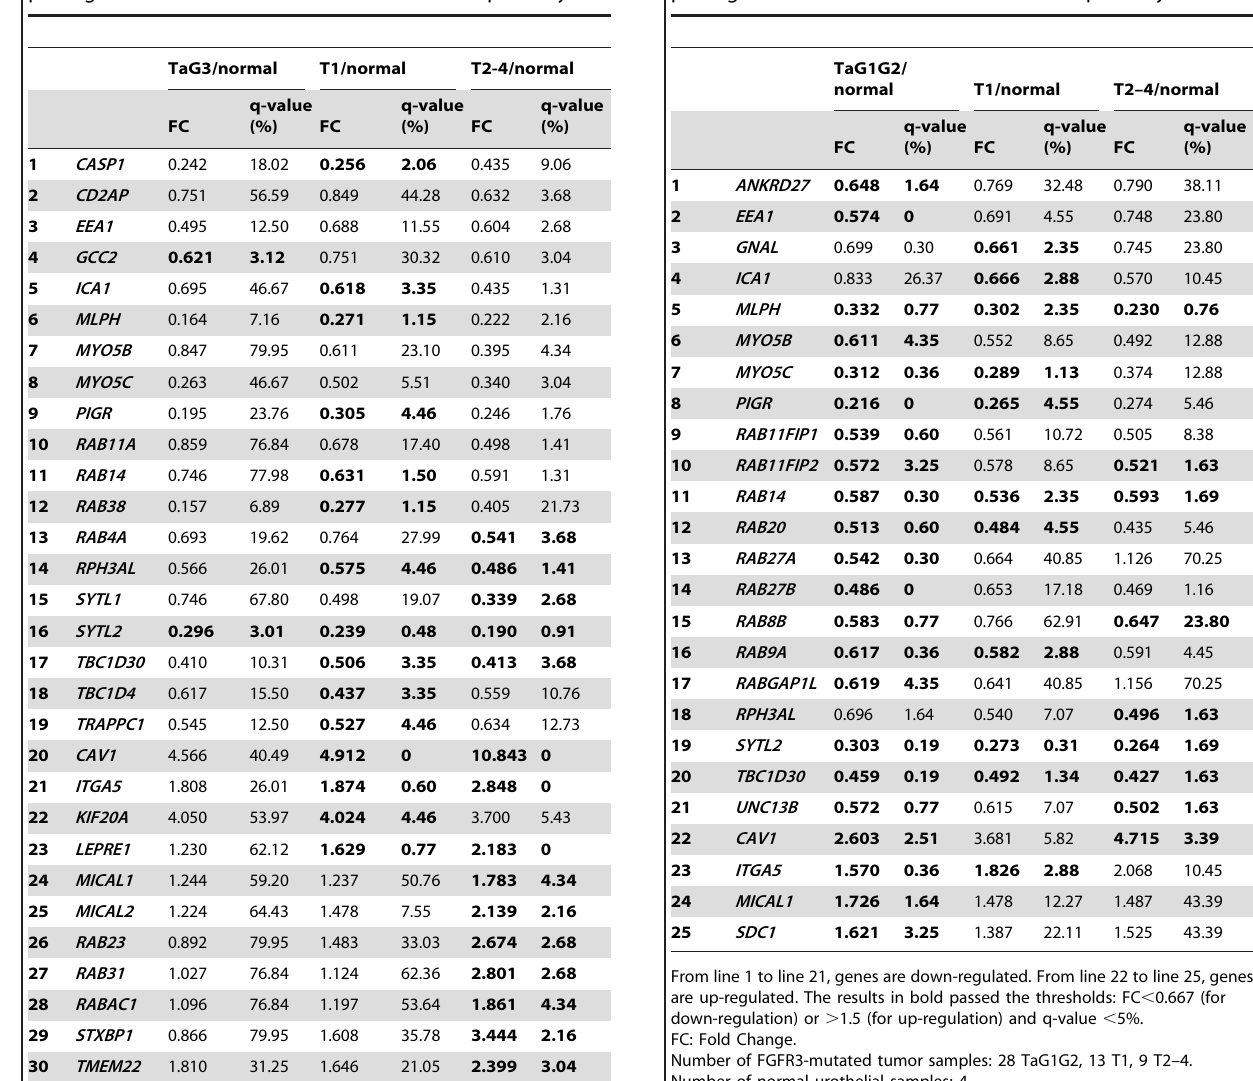
Table 3. Deregulated genes during bladder cancer pathogenesis in the FGFR3 -mutated tumor pathway.